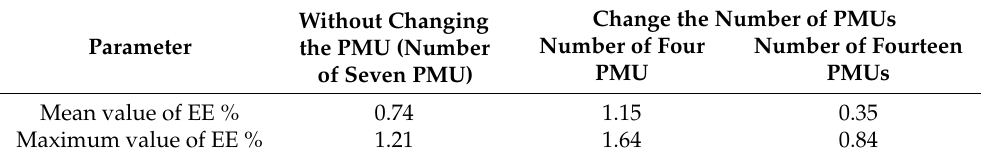
Table 5. Performance sensitivity analysis of the proposed algorithm for the number of PMUs installed in the network.